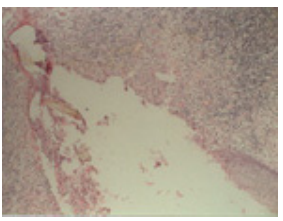
FIGURE 2 . Histology showing sinus containing hair